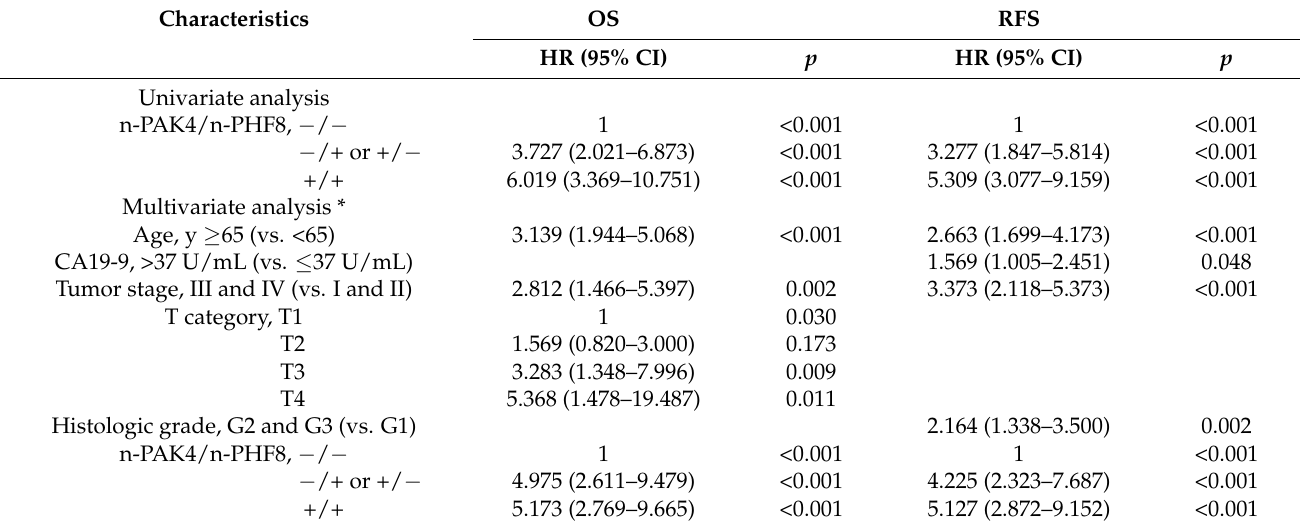
Table 5. Univariate and multivariate Cox regression analysis according to coexpression patterns of n-PAK4 and n-PHF8 in GBCs.